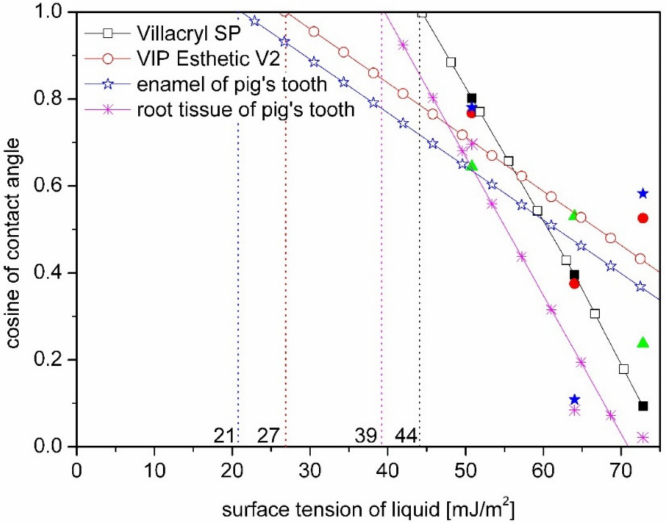
Figure 7. Comparison of the critical surface free energy (marked with vertical lines) for pig tooth, acrylic resin (Villacryl SP) and composite (VIP Esthetic V2) obtained by Zisman’s